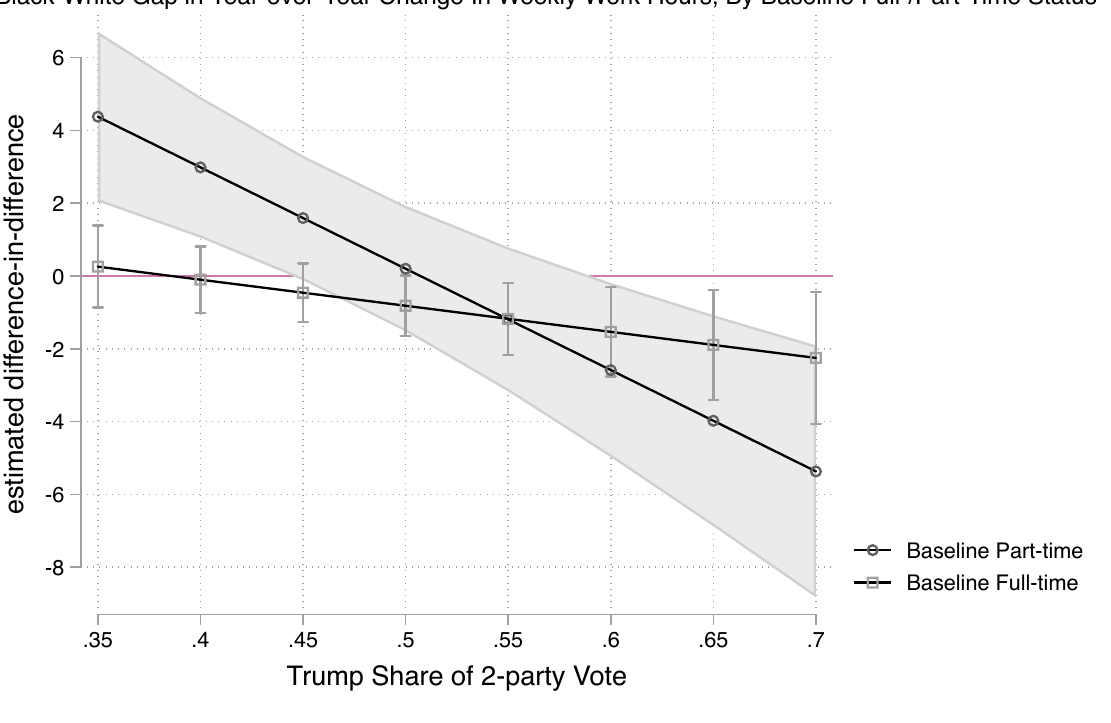
Figure 4: Estimates of year-over-year change in weekly work hours among hourly paid men, by full- and part- time status at baseline. Notes: This figure shows estimates from lagged dependent variable models estimated on sample of prime-age hourly workers employed in the same job year-over-year from November 2015 to March 2017. Models include CBSA, industry, and occupation fixed effects, as well as a triple interaction between local Trump vote share, race, and full- and part-time status at wave 1 baseline. Probability weights are applied to adjust for survey design, sample attrition, and attrition from wave 1 hourly job. Standard errors are clustered by